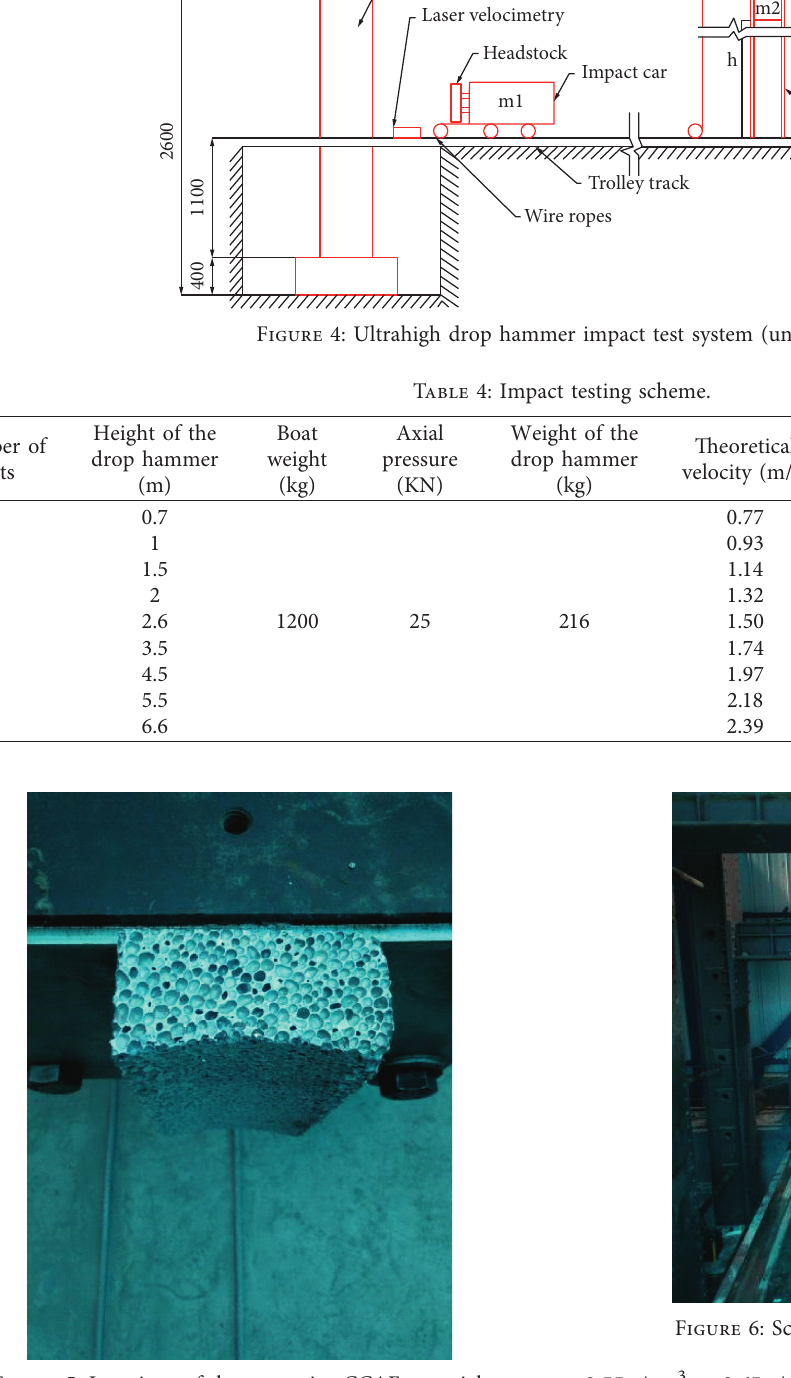
Figure 5: Locations of the protective CCAF material.